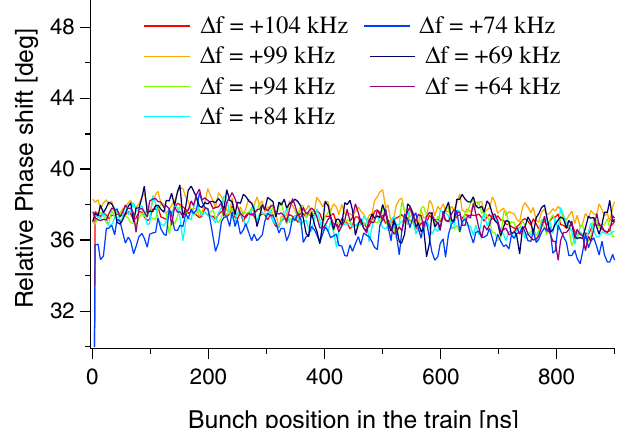
FIG. 7. (Color) Phase difference between the head and the tail of (cid:1) 315 mA , E (cid:1) the bunch train vs the 3HC detuning, for several fractional beam (cid:1) 315 mA , E (cid:1) 2 : 0 GeV . fillings; I beam